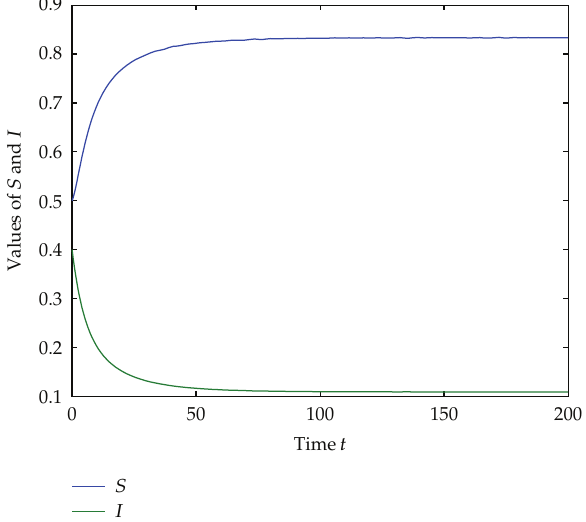
Figure 3: Evolutions of S (cid:5) t (cid:6) and I (cid:5) t (cid:6) for the system with β (cid:8) 0 . 3, δ (cid:8) 0 . 1, α 1 (cid:8) 0 . 2, α 2 (cid:8) 0 . 4, γ 1 (cid:8) 0 . 1, and γ (cid:8) 0 . 05, provided S (cid:5) 0 (cid:6) (cid:8) 0 . 5 and I (cid:5) 0 (cid:6) (cid:8) 0 . 4. 2